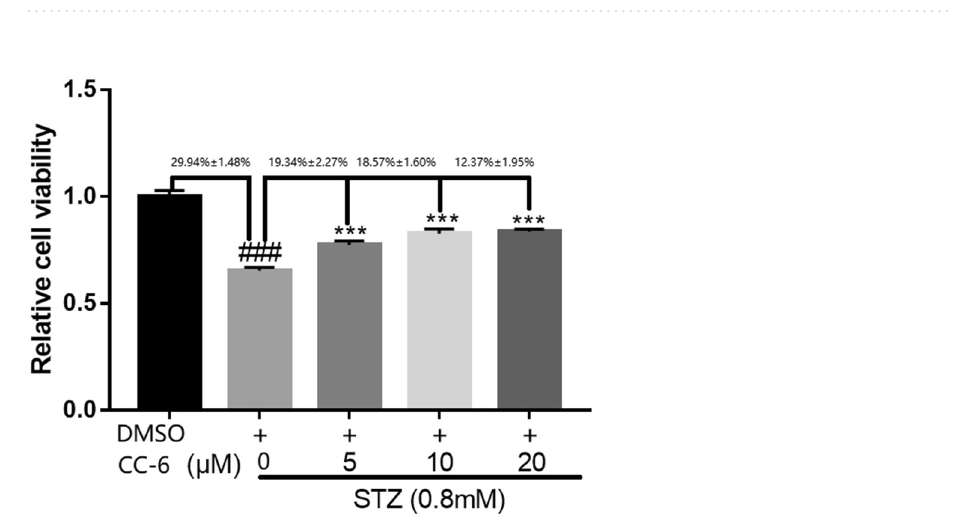
Figure 6. HRMS spectra and UPLC diagram on positive ion flow of CC-6.